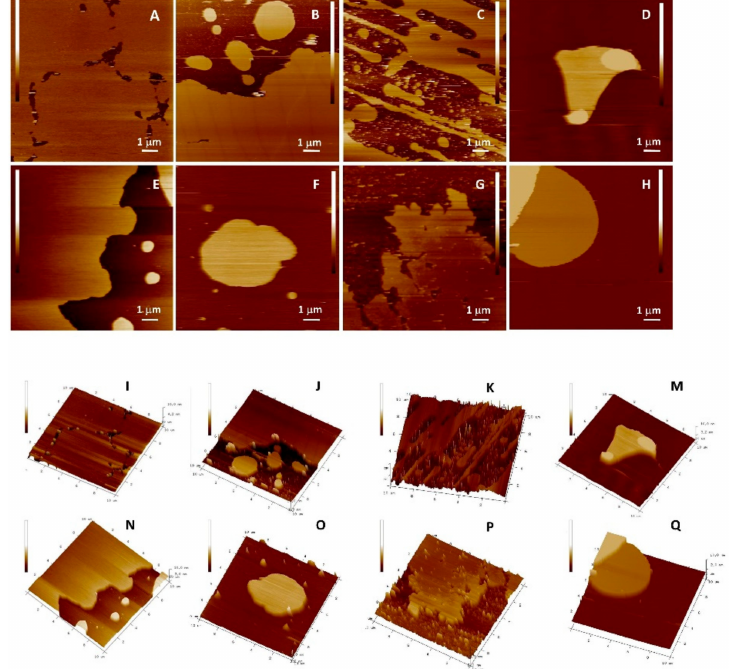
Figure 11. Top view of height AFM images on the model (DOPC) SLB without ( x = 0) and with inserted MCE at di ff erent molar fractions before the induced lipid peroxidation. 2D view: ( A ) DOPC ( x = 0); ( B ) ( x = 0.01); ( C ) ( x = 0.05); and ( D ) ( x = 0.10). 3D view: ( I ) DOPC ( x = 0); ( J ) ( x = 0.01); ( K ) ( x = 0.05); and ( M ) ( x = 0.10). after the induced lipid peroxidation, 2D view: ( E ) DOPC ( x = 0); ( F ) ( x = 0.01); ( G ) ( x = 0.05); and( H )( x = 0.10).3Dview( N )DOPC( x = 0); ( O )( x = 0.01); ( P )( x = 0.05); and ( Q ) ( x = 0.10). Scales of all images are 6